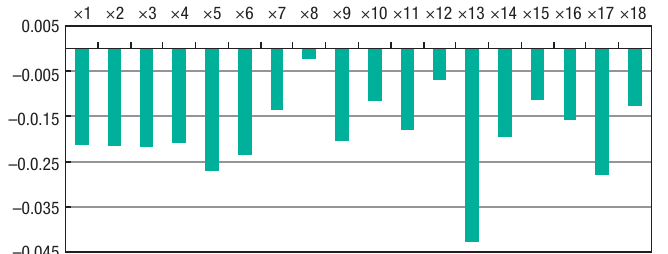
Fig. 4.  CoVaR of 18 sectors